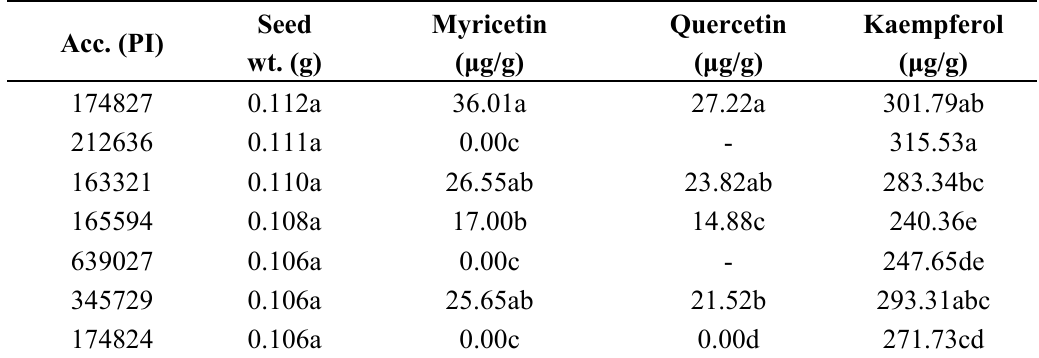
Table 4. Mean seed weight (g) and flavonol concentration ( μ g/g DW) among seven horse gram accessions grown in 2009 and